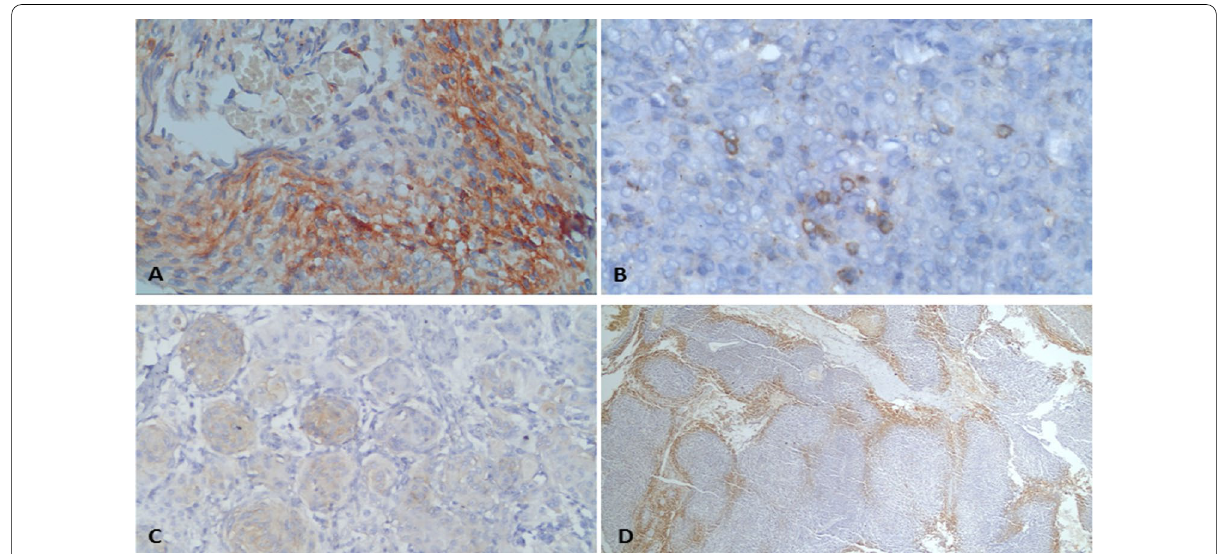
Fig. 2 CD44 expression pattern: A CD44 cytoplasmic expression in meningothelial meningioma (original magnification membranous expression (center of pic) in anaplastic meningioma (original magnification meningioma (original magnification 200). D CD44 expression with peripheral arrangement in atypical meningioma (original magnification ×